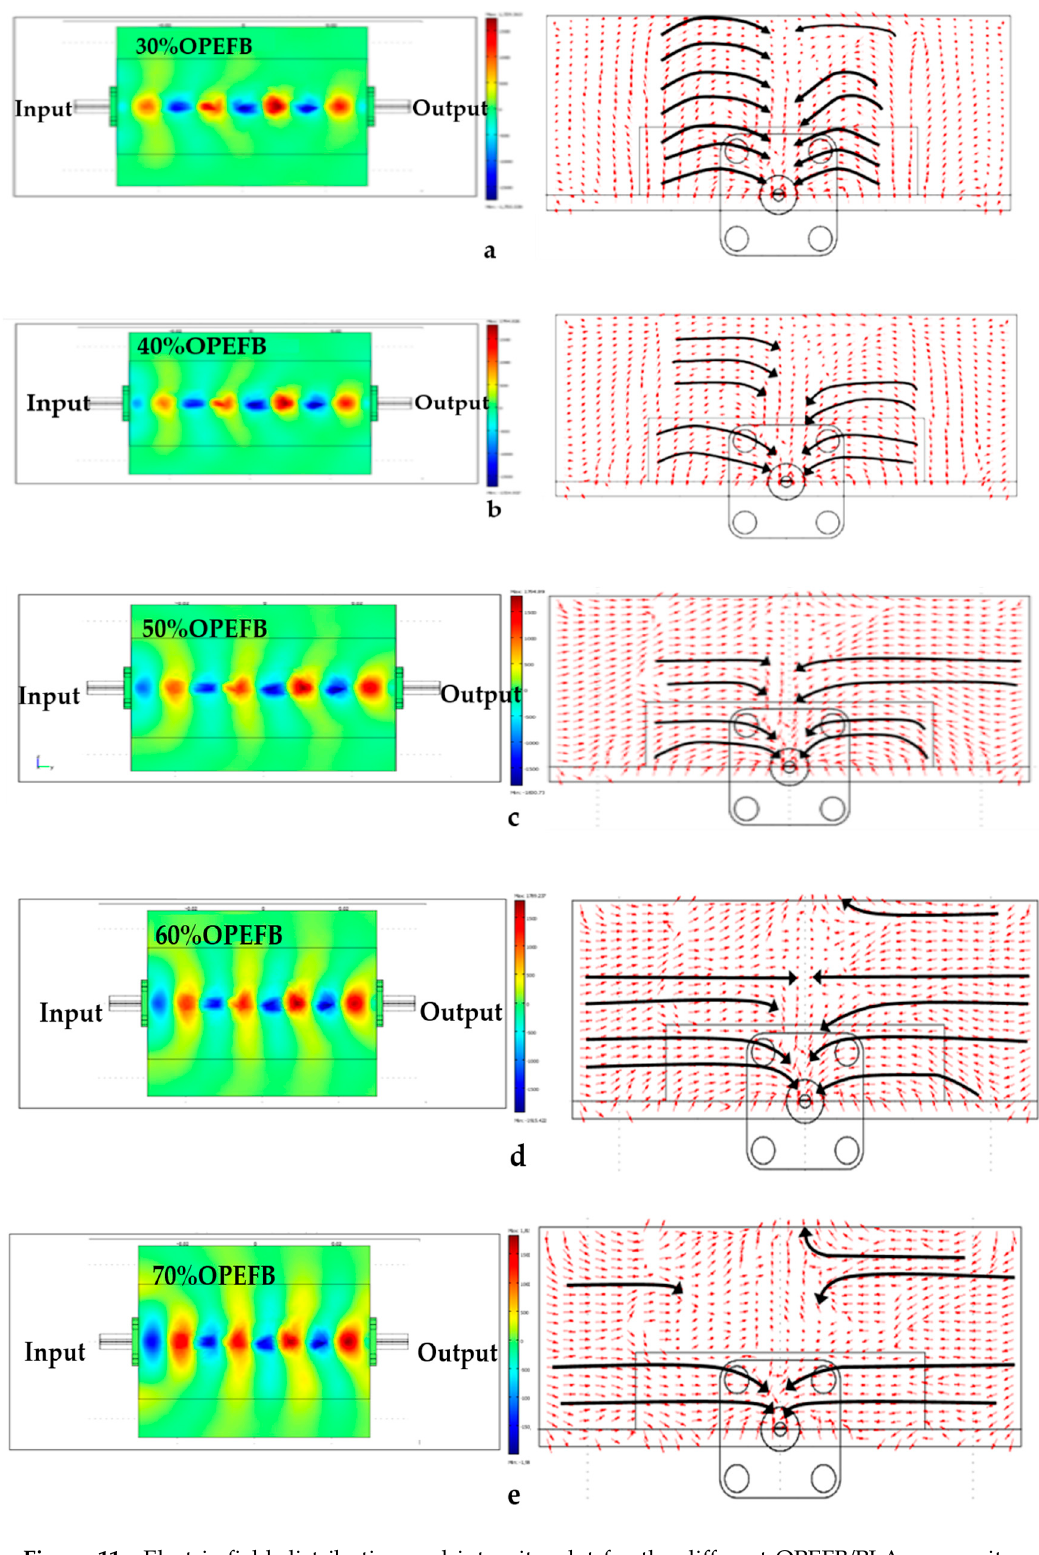
Figure 11. Electric field distribution and intensity plot for the di ff erent OPEFB / PLA